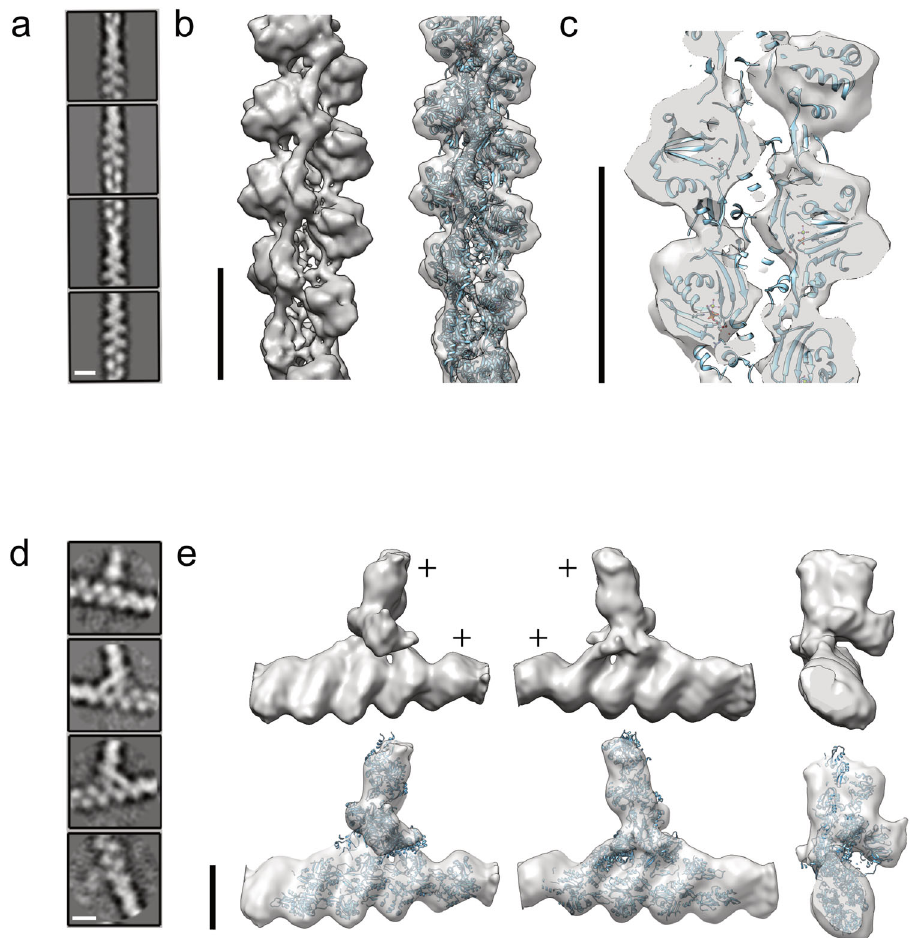
Fig. 2 Three-dimensional reconstruction of actin and the Arp2/3 complex. a Representative 2D class averages of actin segments, 36 nm in length, analyses from cryo-tomograms of spreading cells. b The structure of actin fi laments resolved to 14.4 Å (Supplementary Fig. 4a). Cryo-EM structure of actin EMD-15106 was docked into the structure reconstructed from in situ cryo-tomograms. c A cutaway view through the in situ actin structure indicates the quality of fi tting of the in vitro structure. d 2D class averages of Arp2/3-mediated branches, identi fi ed by template matching (see methods section). e Reconstructed structure of actin branches at 26 Å resolution (Supplementary Fig. 4b). The direction of actin barbed end is labeled with ‘ + ’ . The structure of the extracted branches (EMD-11869) was docked into the in situ reconstructed structure (lower panel). Scale bar: 8 fi laments have their barbed ends towards the membrane (Fig. 3b, left, dark gray). While in the membrane distal area (360 – 400 nm